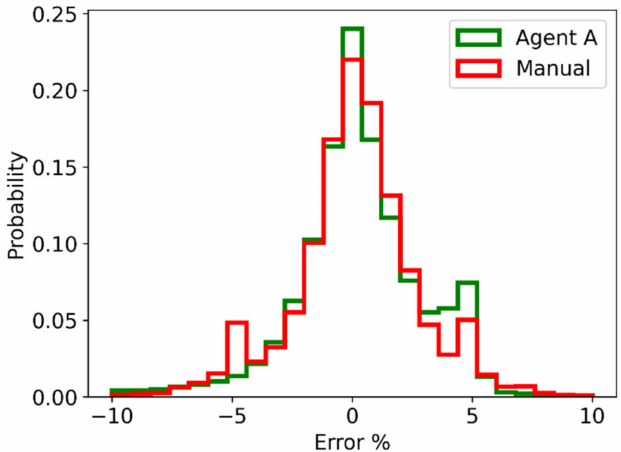
Figure 9. Sump feed water control loop histogram of SV tracking error as a percentage of the